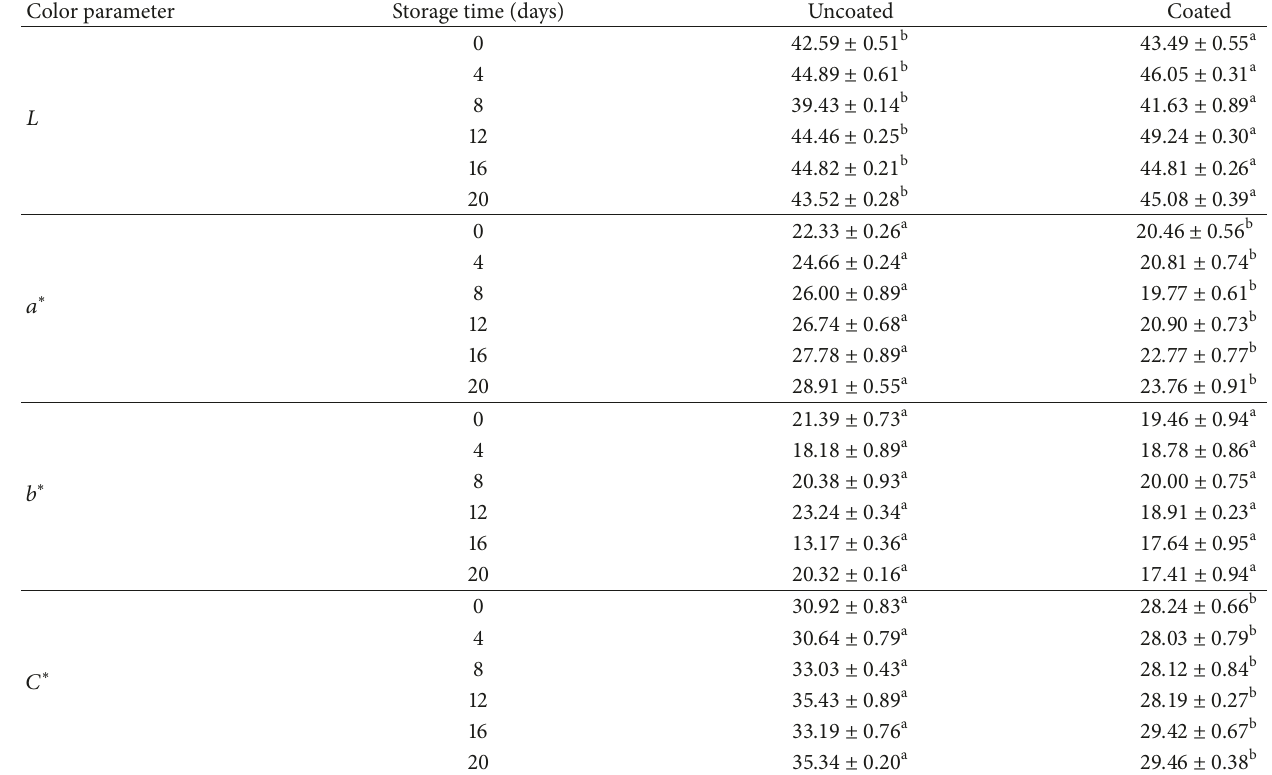
Table 1: Changes in 𝐿 , 𝑎 ∗ , 𝑏 ∗ , and chroma ( 𝐶 ∗ ) color values of guar gum coated tomatoes at different storage time intervals. Color